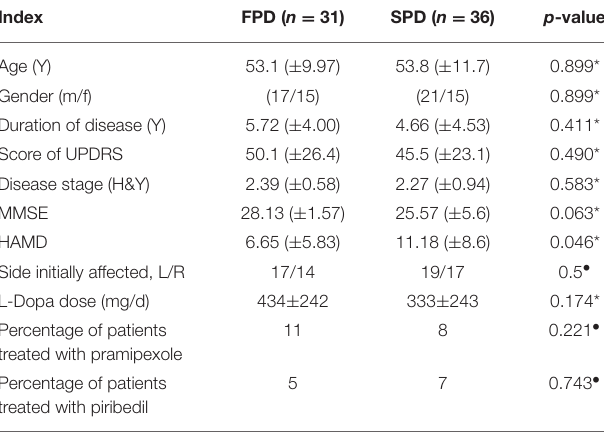
TABLE 1 | Clinical and demographic